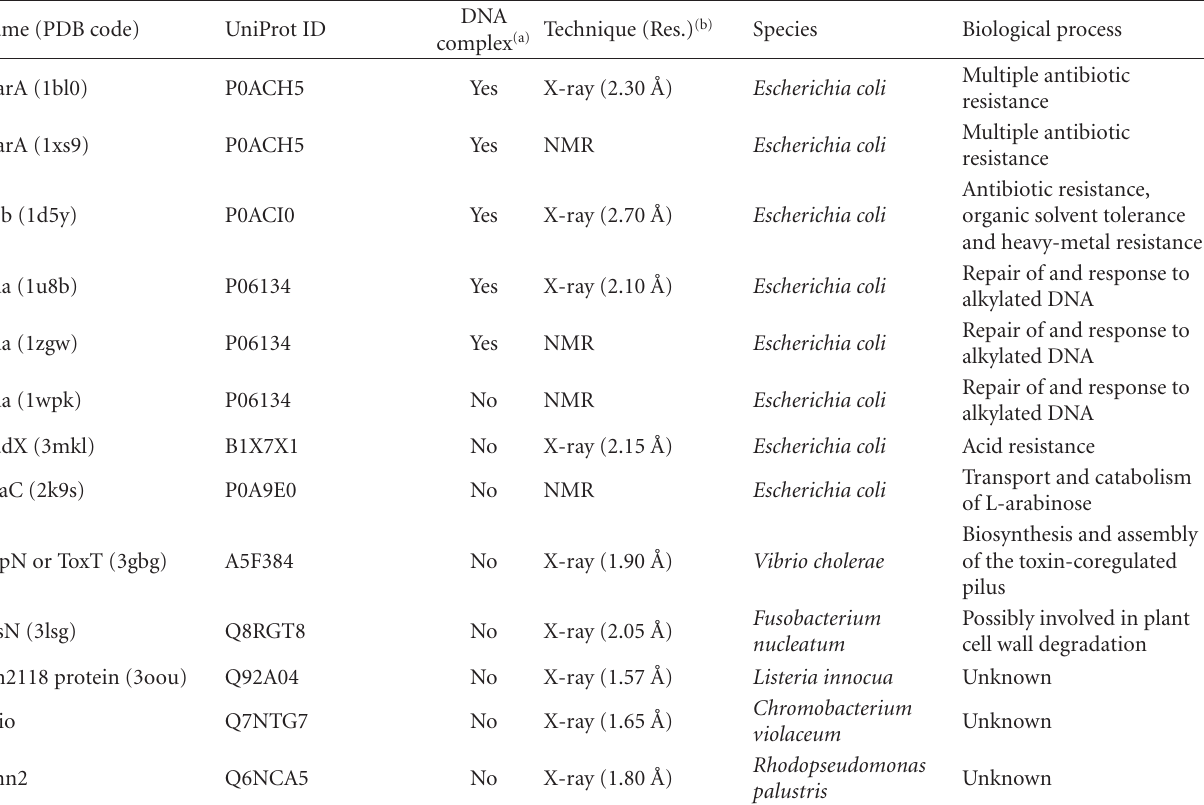
(a) Indicates whether the 3D protein structure was cocrystallized with DNA or not. (b) Numbers in parenthesis refer to the resolution of crystal structures.